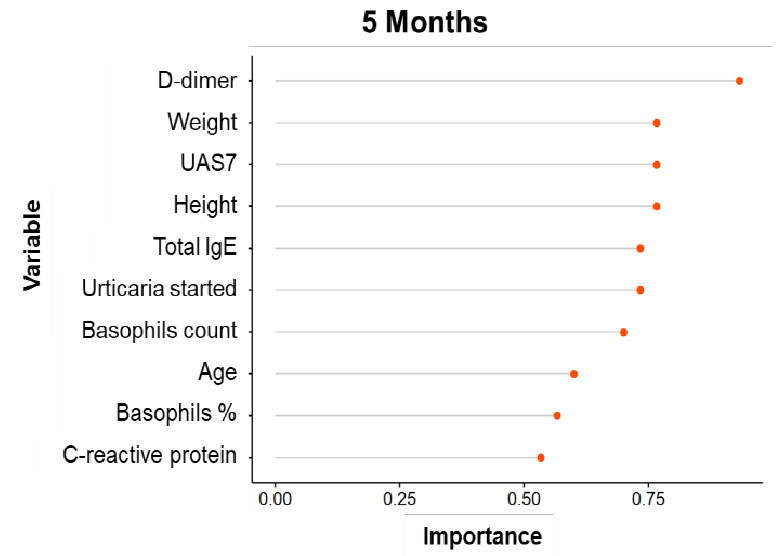
Figure 6. Variable Importance Analysis for the prediction of the response to omalizumab after 5 5 months treatment. months treatment.